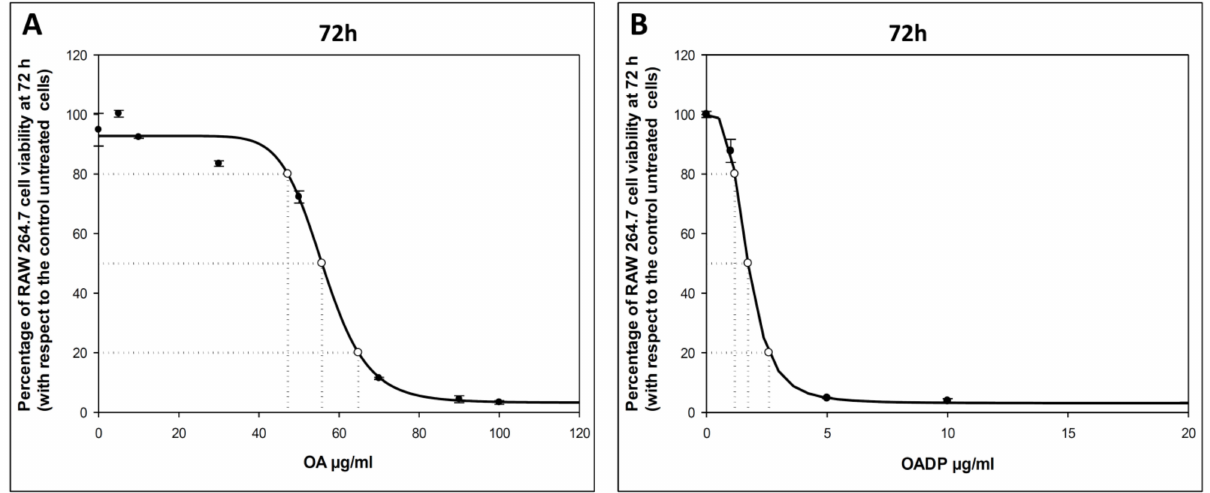
Figure 1. Effect of OA ( A ) and OADP ( B ) on cell proliferation of RAW 264.7 macrophage murine cells, after treatment with the compounds for 72 h. Each point represents the mean value ± S.D. of at least two independent experiments performed in